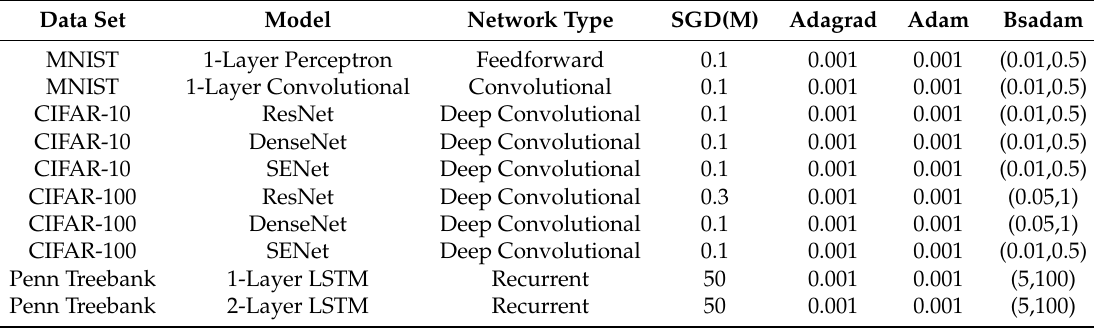
Table 1. Summarizing the models and the data sets utilized for our experiments. The optimal hyperparameters for stochastic gradient descent (SGD) with momentum (M), Adagrad, Adam and Bsadam for all experiments are also